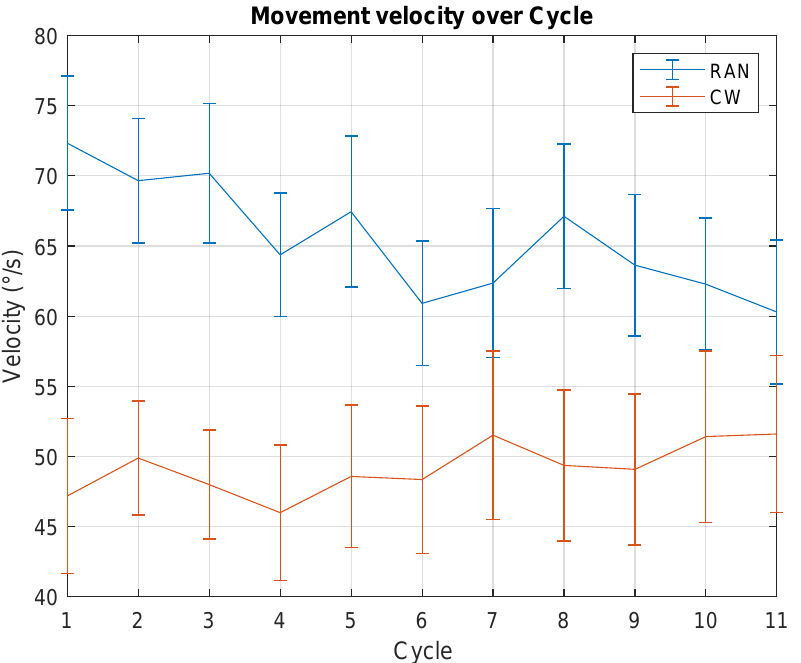
Figure 9. Movement velocity (MV), over cycles, for RAN (blue) and CW (red) modes. MV is obtained through the movement time, as described in Figure 5.